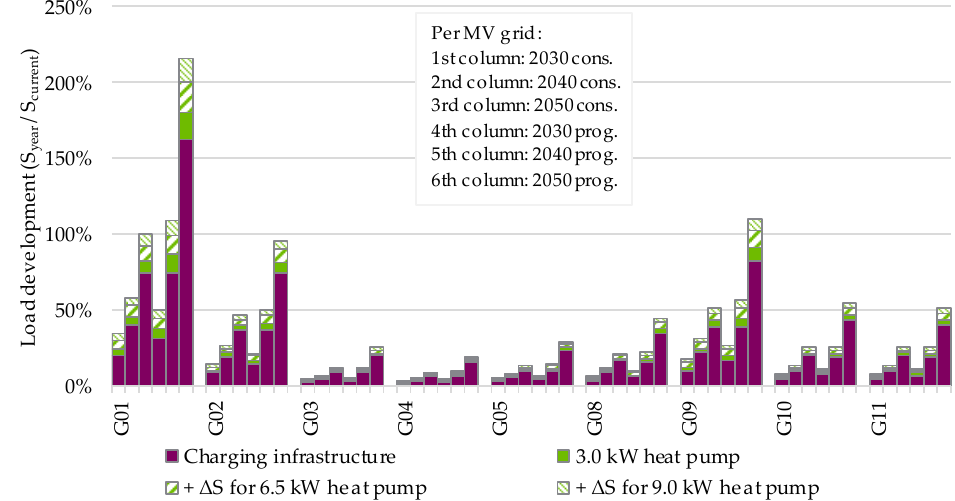
Figure 15. Load development for the two development scenarios and the years 2030, 2040, and 2050 in relation to the current load power based on [59].